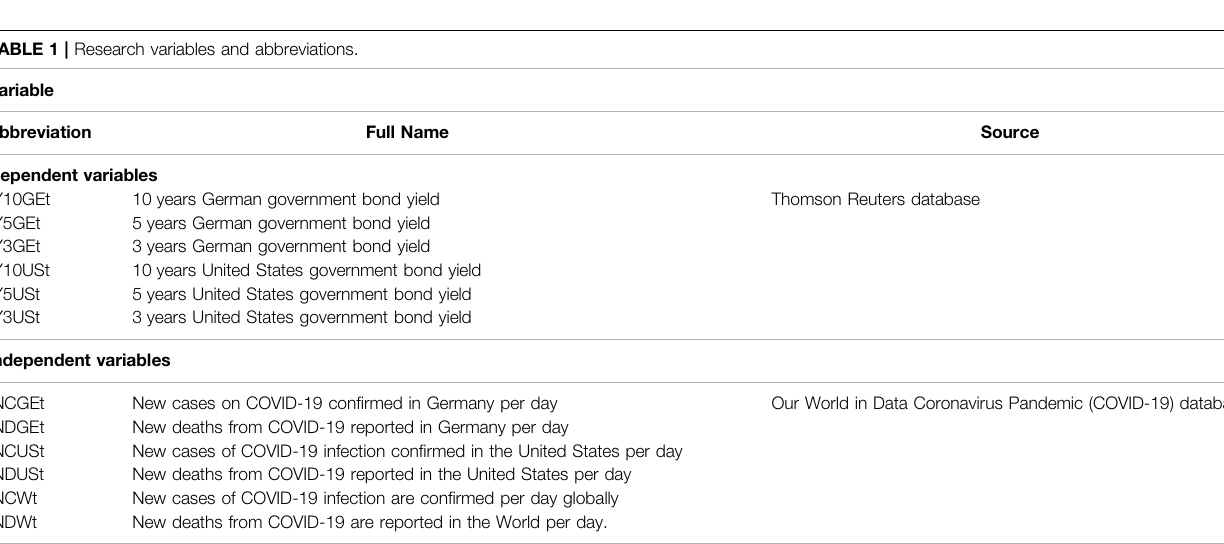
TABLE 1 | Research variables and